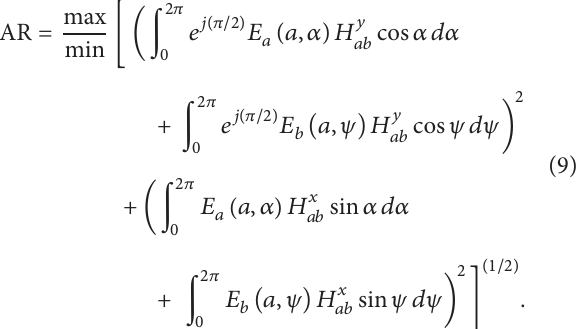
Figure 3: Resonant resistance versus different feed